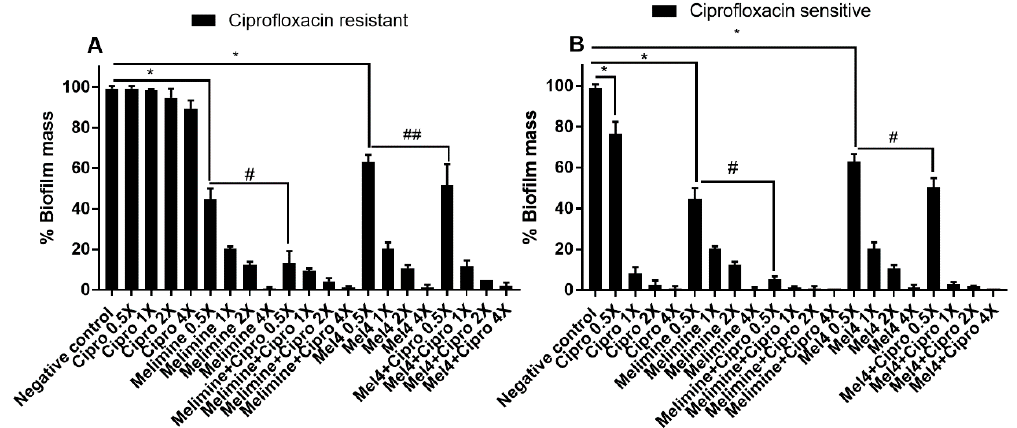
Figure 3. Inhibition of biofilm formation of P. aeruginosa ATCC 27853. Biofilm formation of the ciprofloxacin-resistant ( A ) or sensitive ( B ) cells of P. aeruginosa ATCC 27853 was inhibited by various concentrations of melimine, Mel4 and ciprofloxacin alone or in combination. The strain was made resistant to ciprofloxacin by sub-passage for 30 days at a sub-MIC concentration (Section 4). * represent significant ( p < 0.001) decreases compared to the negative control (bacteria grown in the absence of antibiotics). # indicates significant ( p < 0.001) decrease for the combinations compared to melimine or Mel4 alone while ## indicates p = 0.051 compared to Mel4 alone. Means ( ± SD) of three independent repeats in triplicate. Negative control = bacteria grown in the absence of antimicrobials, Cipro = ciprofloxacin.